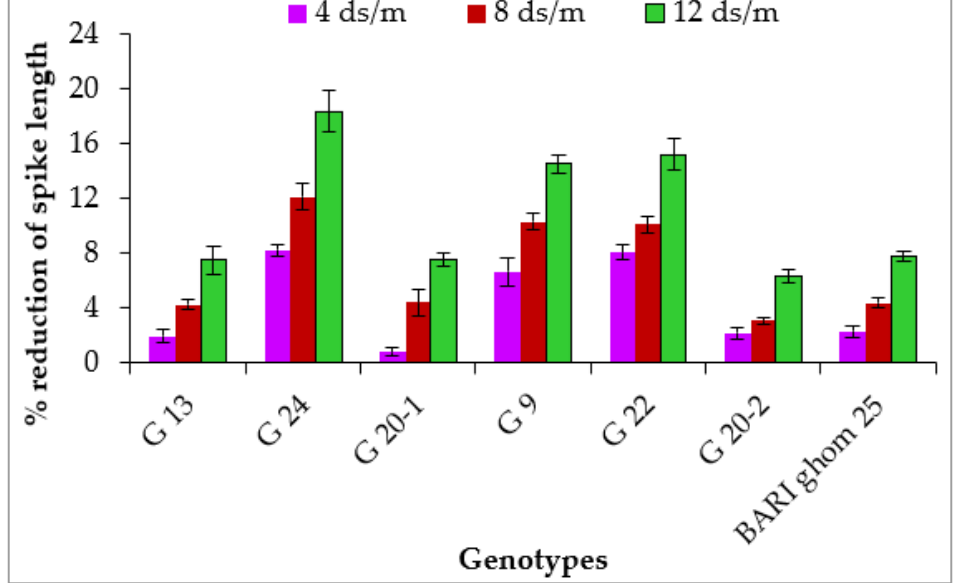
Figure 4. Reduction (%) of spike length of wheat genotypes under various salinity levels. The vertical bar indicates average of five independent replicates ( n = 5). Error bars represent standard error.